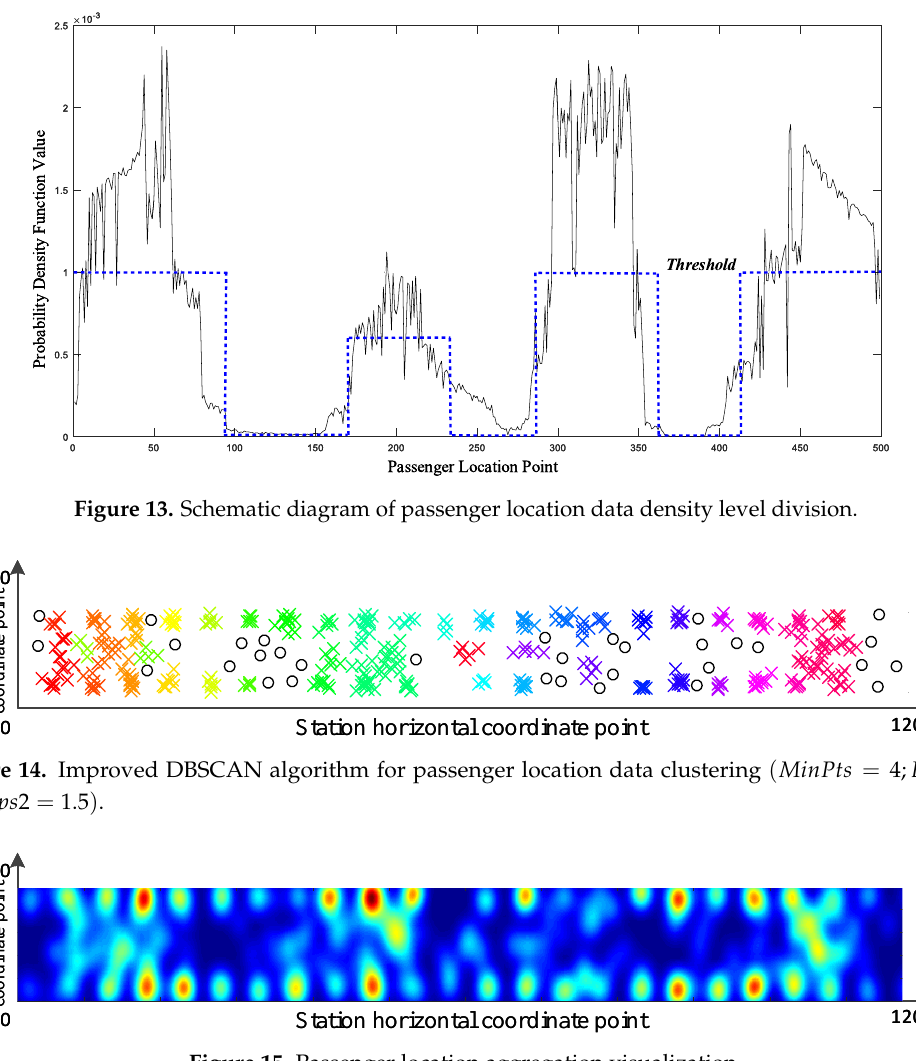
Figure 15. Passenger location aggregation